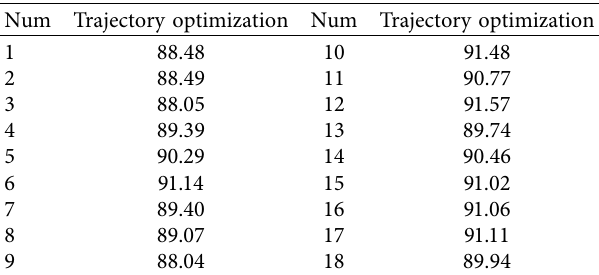
Figure 8: Variation of 10 times RMS of MEA-BP and BP forecast (a) (b) (c). Table 1: Evaluation of aircraft flight trajectory